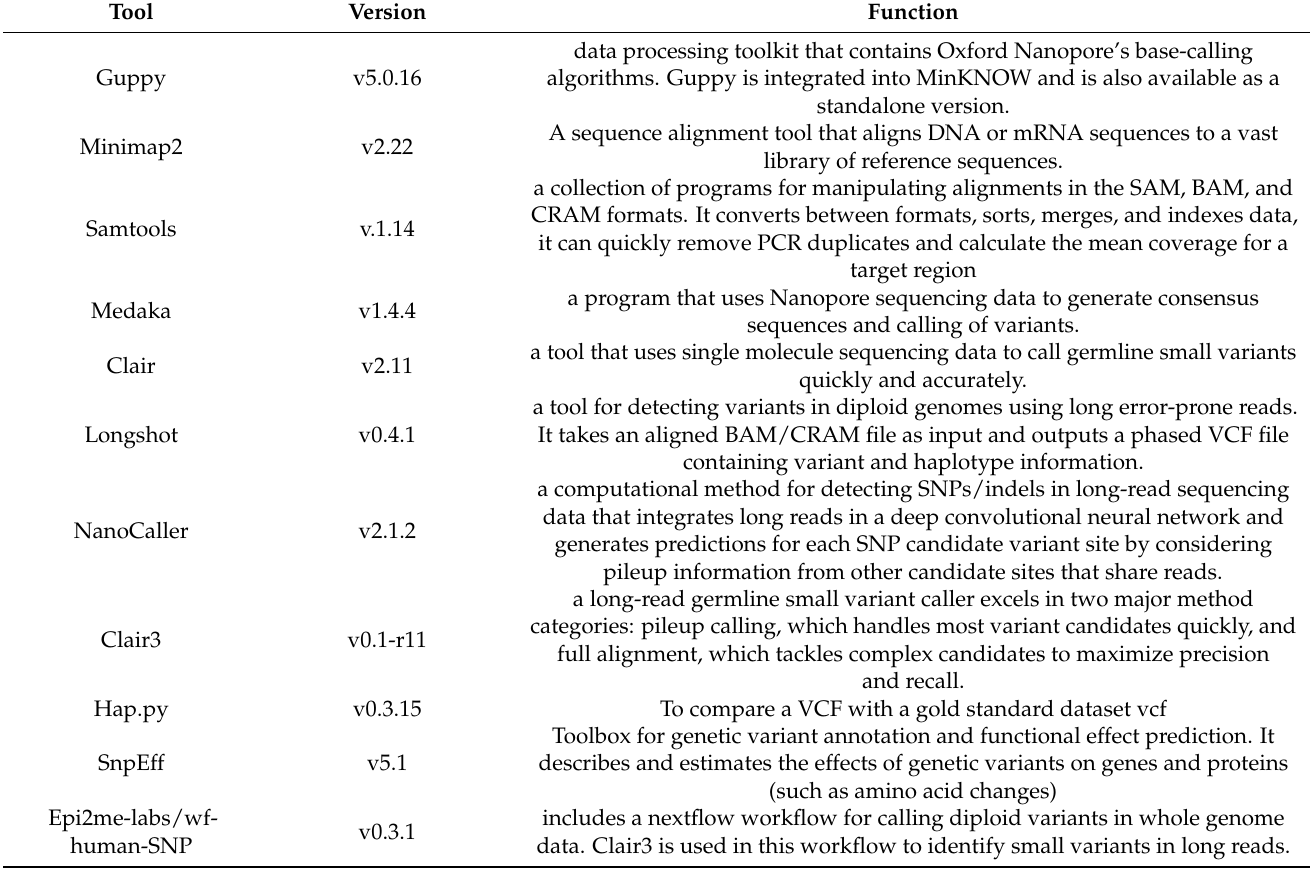
Table 1. Summary of the tools used in both SNP and indel